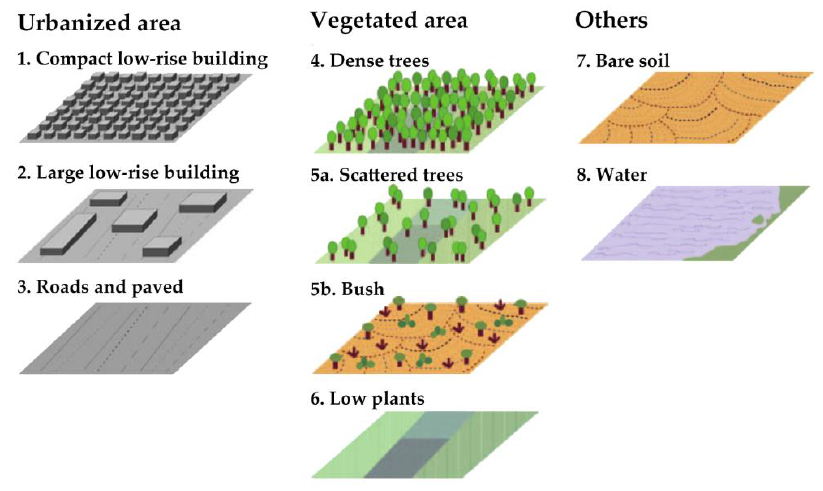
Figure 2. Illustration of Local Climate Zone. Corresponding LCZ images are reproduced from Stewart and Oke [16], American Meteorological Society, Used with